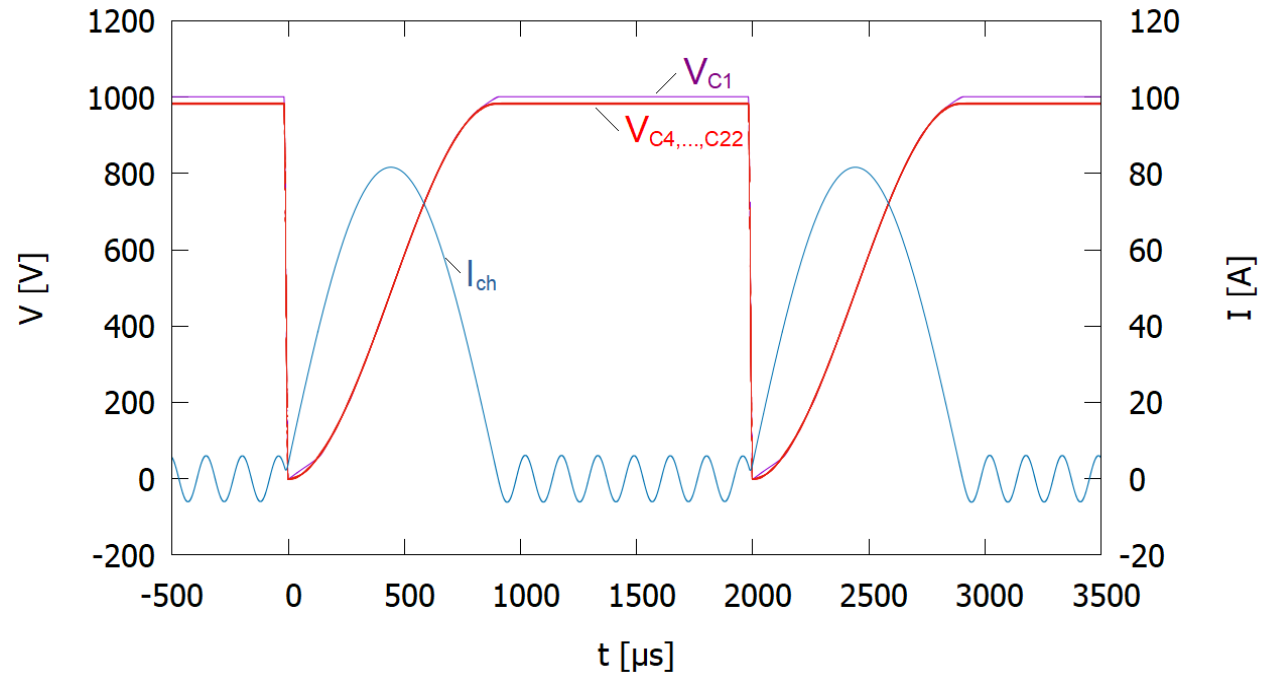
Figure 9. Simulated voltages across the stage capacitors C1, C4, C7, C10, C13, C16, C19, and C22 according to Figure 3, together with the generator’s charging current I ch (R D = 20 Ohm).